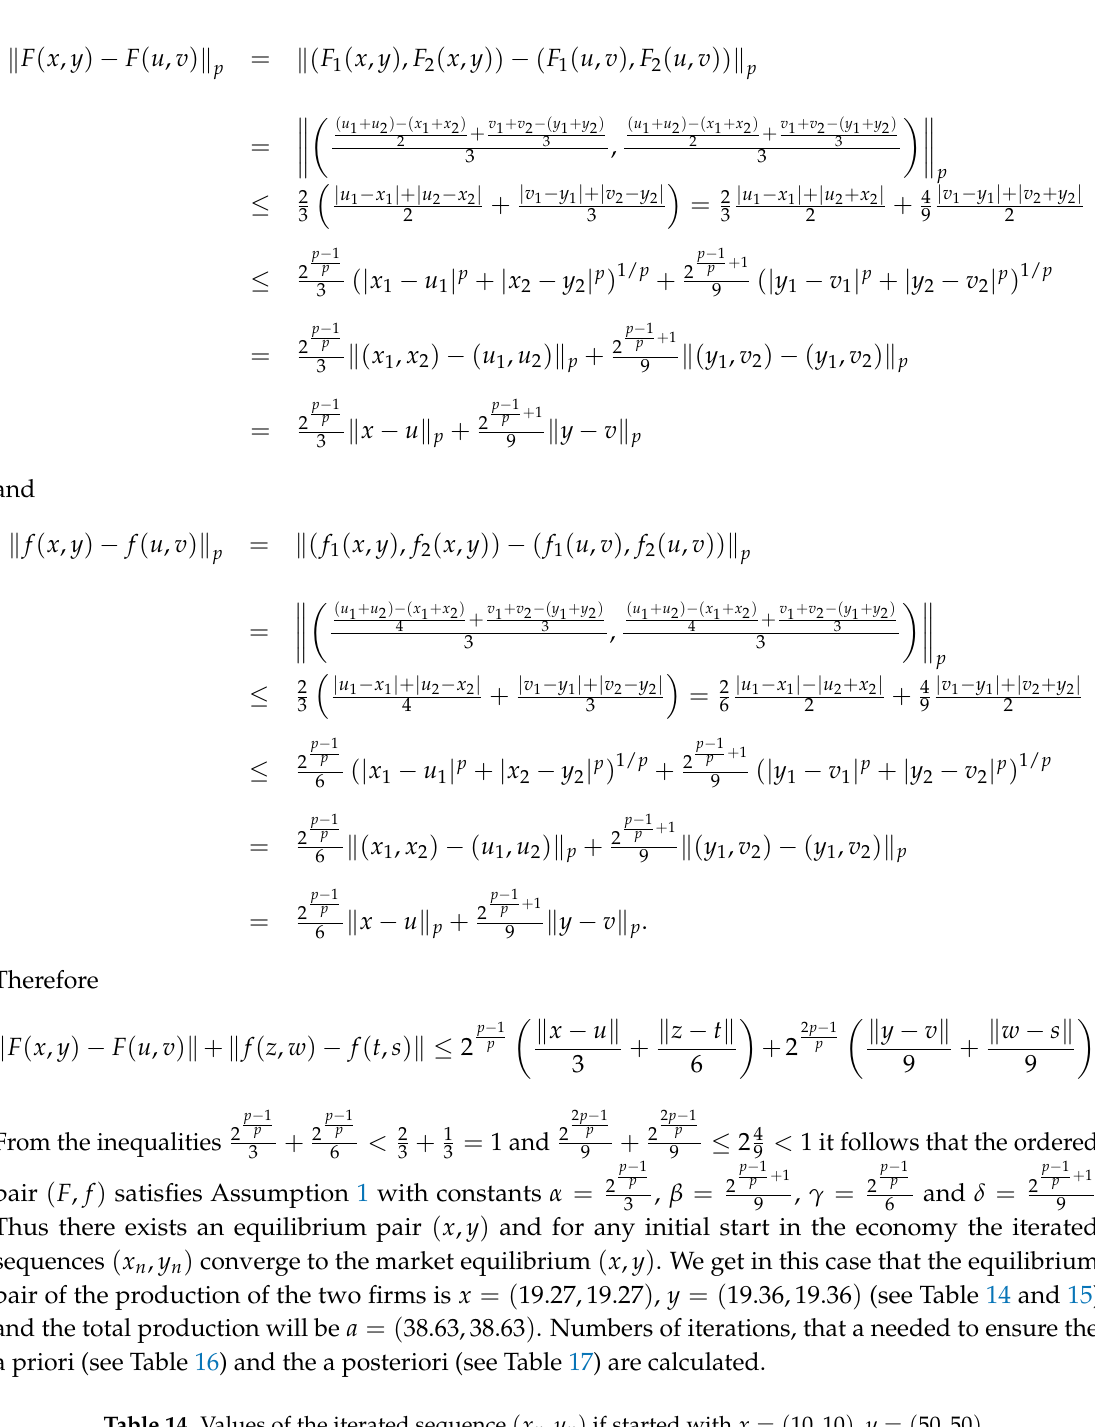
Table 14. Values of the iterated sequence ( x n , y n ) if started with x = ( 10,10 ) , y = ( 50,50 ) .